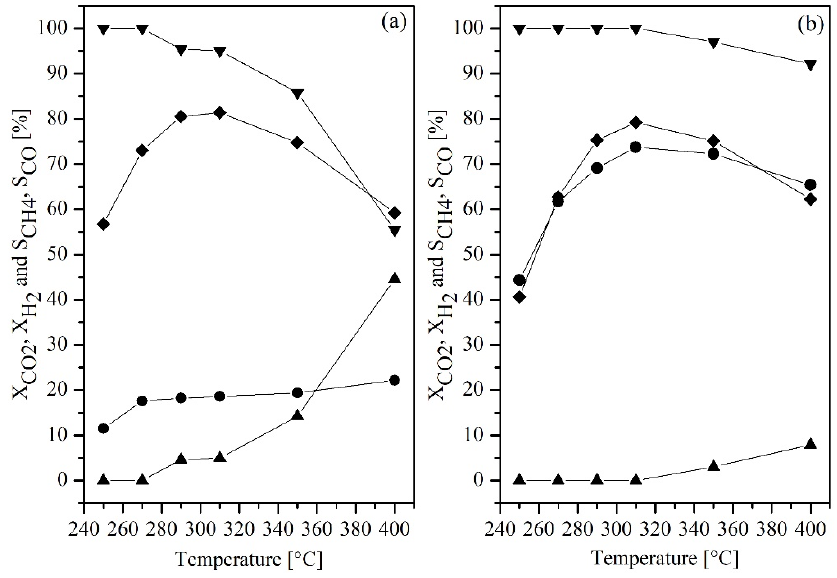
Figure 7. CO 2 ( ● ), H 2 ( ♦ ) conversion and CH 4 ( ▼ ), CO ( ▲ ) selectivity over 40 wt% Ni-CeO 2 /Cr 2 O 3 catalyst as a function of temperature and various H 2 /CO 2 molar ratio; ( a ) 2:1 and ( b ) 4:1 with WHSV = 56,500 ml N · h − 1 · g − 1 cat